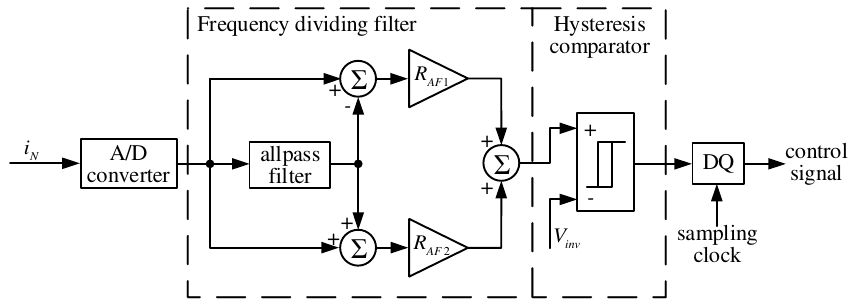
Figure 12. A block diagram of control signal computation for single-phase inverter.